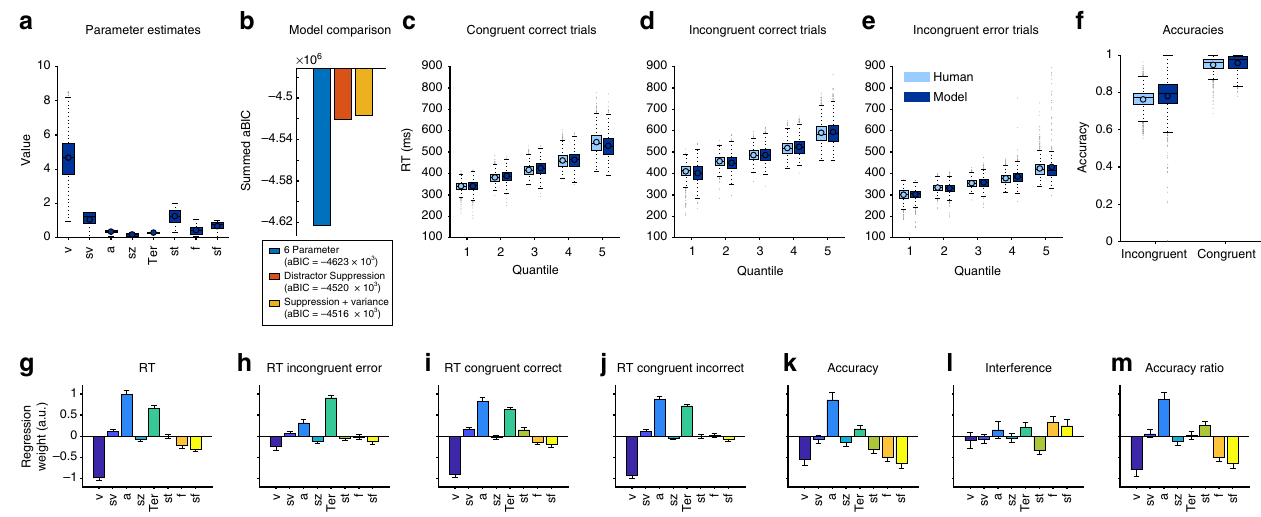
Fig. 2 Drift-diffusion model fi ts and parameters. The drift-diffusion model (DDM) included eight free parameters ( a ). Apart from the standard-parameters re fl ecting drift rate ( v ), boundary ( a ), and non-decision time ( Ter ), we included variance parameters that determined how much standard-parameters varied from trial-to-trial ( sv , sz , st , cf. Supplementary Fig. 1). Model comparisons ( b ), revealed that two additional free parameters for distractor weighting ( f , red) and it's trialwise variance ( sf , yellow) increased model fi t measured as approximate BIC (see Supplementary Figure 2 for results of worse fi tting models). f varies with variance sf over trials and modulates fl anker processing by scaling the drift rate during distractor presentation. ( c – e ) shows quantile fi ts of the model (dark blue) against human RT data and ( f ) shows model and human accuracy. In all conditions (congruent & incongruent correct as well as incongruent error), the model captures the RT data in each quantile, suggesting a good fi t to the data. Plot conventions as in Fig. 1b. Note that we removed congruent errors from the analysis as these were very rare (<2.5% of trials). g – m Displays the relationship between model parameters and behaviour across subjects. Displayed are regression coef fi cients and 99.9% con fi dence intervals. g Faster participants were fi t by higher drift rates, lower decision boundaries, and lower non-decision times. h – j RT on error trials h was most strongly dependent on the non-decision time because errors are usually very fast, whereas drift rates are more closely associated with RT on correct congruent ( i ) and incongruent ( j ) trials. k Accuracy was most strongly re fl ected in the height of the boundary ( a ) but additionally dependent on how much distractors were processed ( f ) and how variable their suppression from trial-to-trial was ( sf ). Higher variance reduces accuracy, because in more trials distractors are likely to not be suppressed. l Interference and the ratio of errors between incongruent and congruent trials ( m ) additionally covaried with distractor weighting and its variance ( f , sf ): the less fl ankers were suppressed in the model, the higher was the interference and the more incongruent compared to congruent errors a participant made